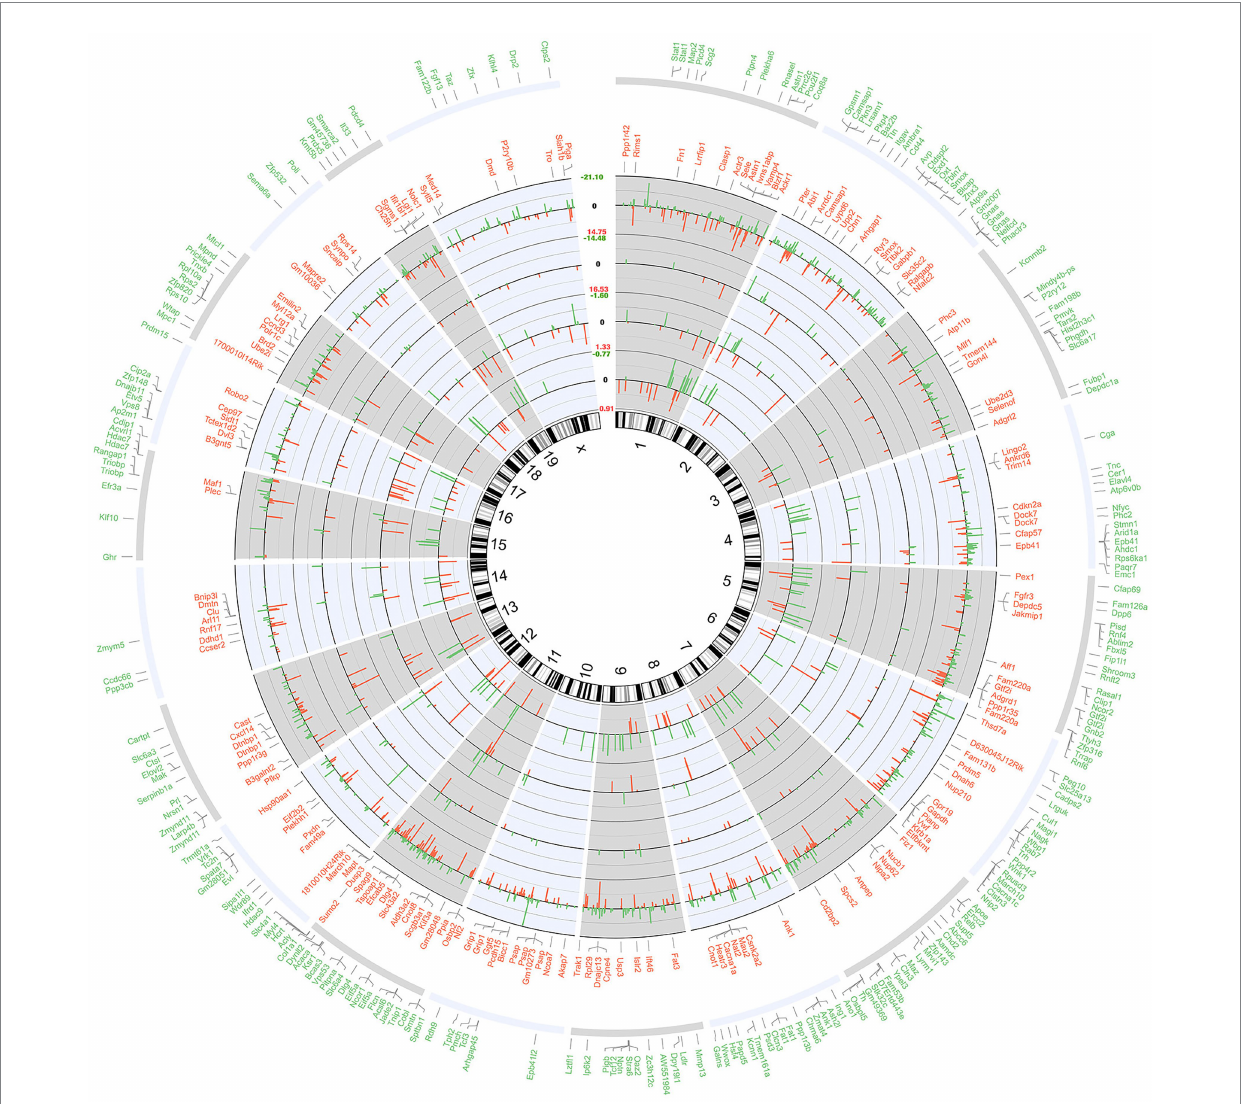
FIGURE 2 Circular ideogram of the whole transcriptome gene expression. The chromosomal location annotated in a clockwise manner, and the black innermost ring (with vertical lines) represents autosome ideograms (annotated is the chromosomal number), with the pter-qter orientation in a clockwise direction. From the inside to the outside, there were three histograms of gene expression of the 177 DEcircRNAs, 222 DEmiRNAs, and 2,052 DEmRNAs. Red bars inside the ideograms mark genes with increased expression ( p < 0.05), whereas green bars outside mark those with decreased expression ( p < 0.05). The length of each bar represented the level of difference (fold change, FC), and the log 2 FC of the RNAs were shown in the blank between chromosome 1 and X. The top 20% protein coding genes (in the descending order of p value) that match the Ensemble gene database are listed in the two outermost circles. Red words mean top 20% increased genes (168) and green words mean top 20% decreased genes